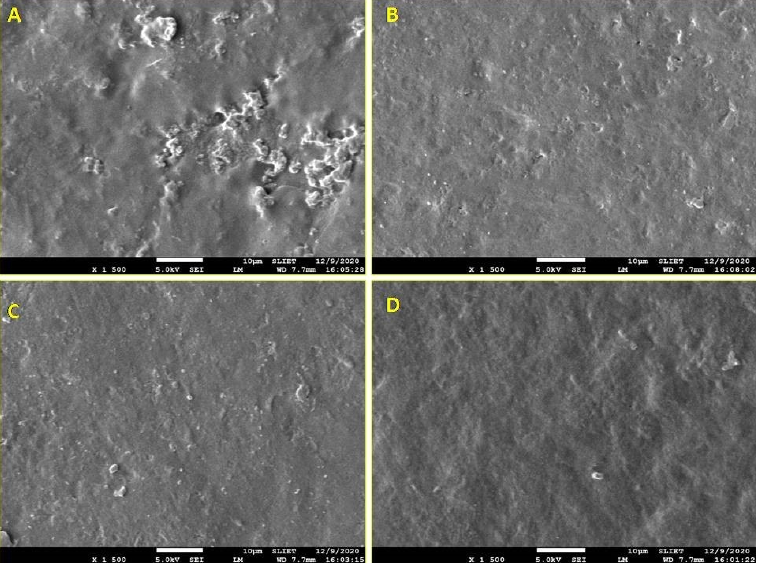
Figure 3. SEM image ( × 1500 magnification) of FPC edible film made at pH 9, pH 10, pH 11, and pH 12 shown as ( A – D )